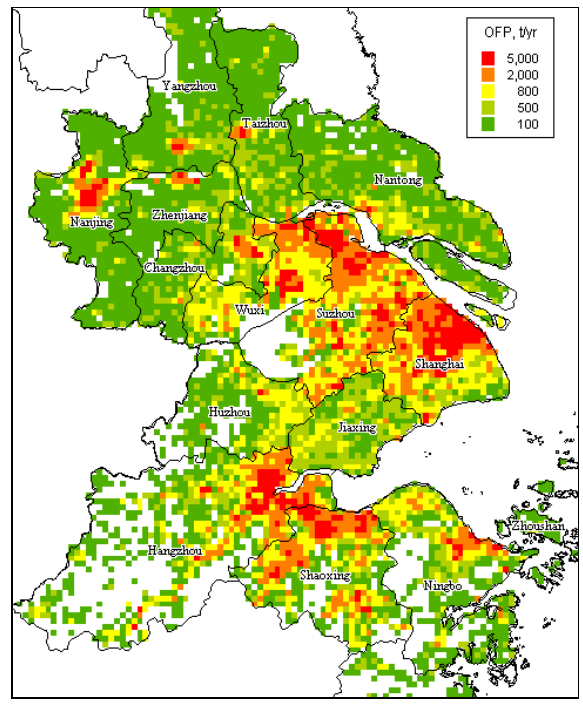
Fig. 7. Spatial distribution of the OFPs in the YRD region. sources, were collected from the local pollution source cen- sus in the YRD region. However, most of the emission fac- tors used in this study is still subject to considerable uncer- tainty due to the lack of local measurement data. Table 8 illustrates the uncertainty analysis at the 95 % confidence in- terval for each source category in the emission inventory. The coefficients of variation of the activity and emission factor data of each source are classified into seven grades in the range of 2 %–100 % based on expert judgment. The coeffi- cient of activity data is determined based on the quality of data source. The census data of the industrial sources are assigned the lowest coefficient of uncertainties, while the es- timated activity data based on statistical yearbooks such as biomass burning are assigned the highest values. The coeffi- cient of emission factor is mainly determined by its source. The emission factors based on local measurements with large samples are assigned the lowest values, while those from lim- ited European or American studies are assigned high coef- ficients. Then the uncertainty of each pollutant from each emission source is combined by Eqs.